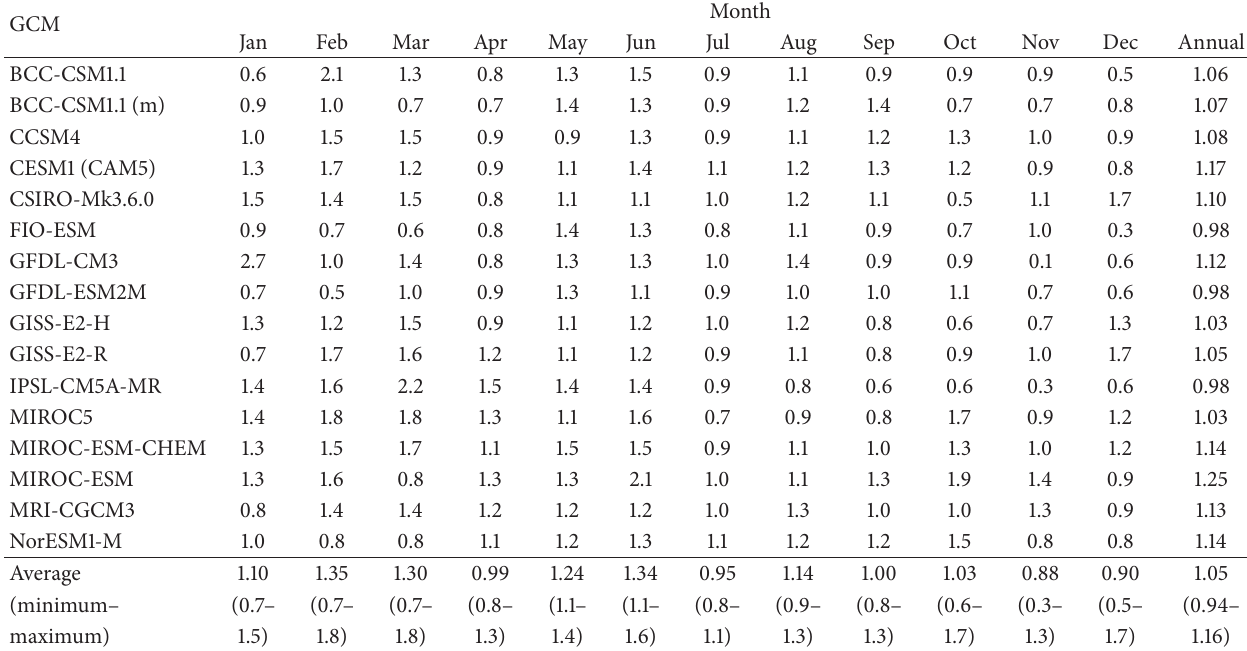
Table 4: Changes (represented by ratios of the 2x CO 2 condition with respect to the 1x CO 2 condition) of monthly rainfall amounts predicted by several GCMs (average, minimum, and maximum values were decided after excluding the lowest and highest predictions each month).